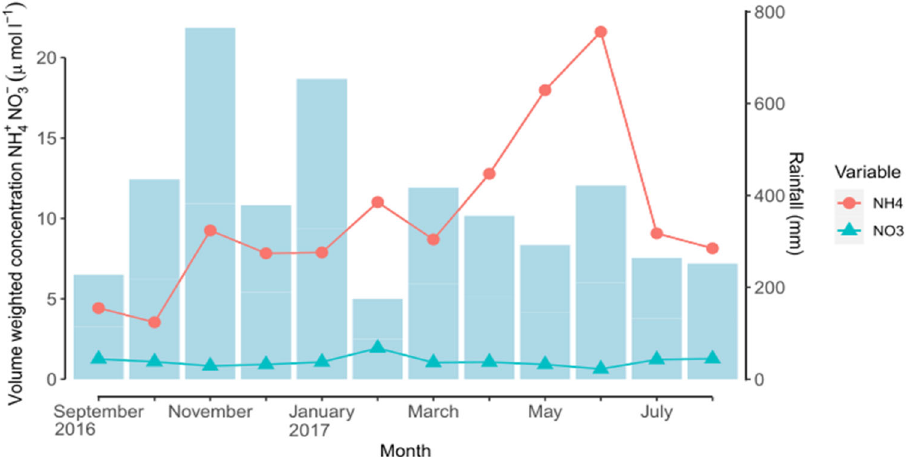
Figure 2. Total monthly rainfall at our study site in Sepilok, Sabah, Malaysia (blue bars) and volume ‐ weighted mean concentration of rainfall NH 4+ and NO 3 − . Table 1. Monthly mean pH and the cumulative amount of wet NH 4+ -N and NO 3 − -N (kg ha − 1 ) in rainfall collected in our study site at Sepilok, Sabah,